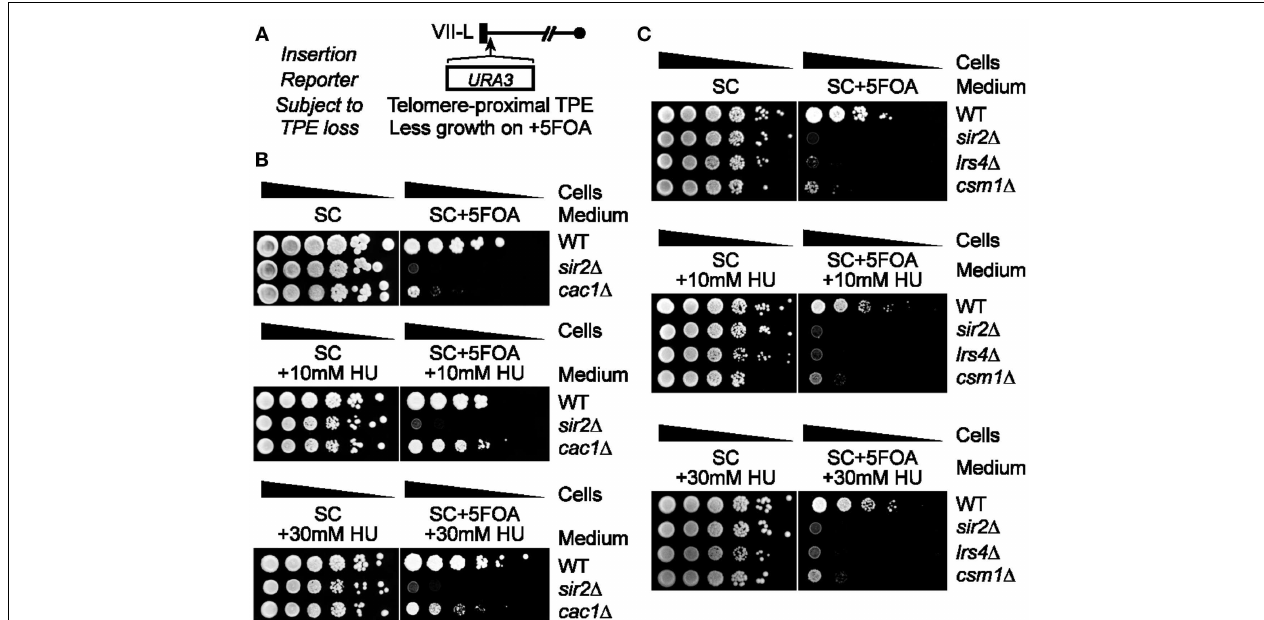
the telomeric URA3 reporter were plated on synthetic complete (SC) medium or medium supplemented with sublethal concentrations of hydroxyurea ( + HU) and/or 5FOA ( + 5FOA).WT, wild-type. Strains: KMY368, KMY416, KMY1465, KMY74,